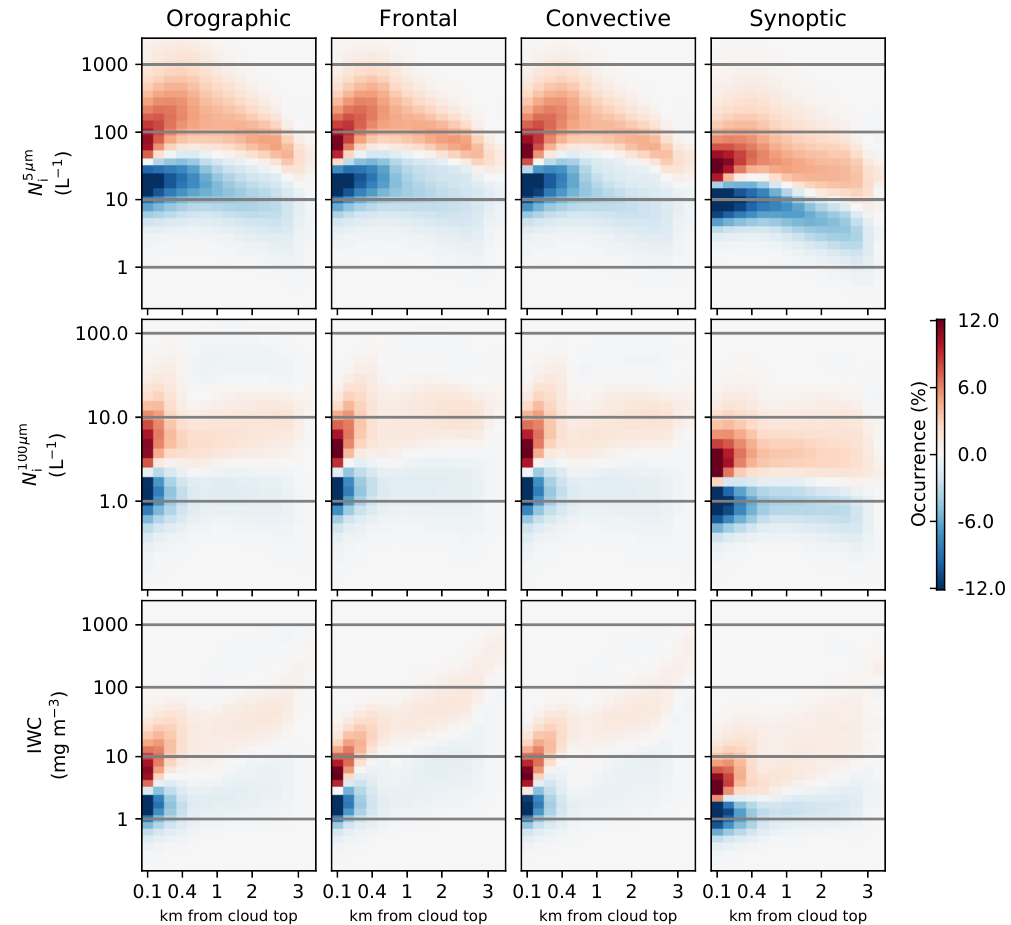
Figure 9. As in Fig. 5, but showing the difference in the retrieved properties depending on the cloud top properties. Red over blue indicates that clouds with above median properties at the cloud top ( N 5µm , IWC ( top ) ) have higher values of the retrieved properties at a specified i ( top ) depth from the cloud top. Note the nonlinear scale on the horizontal